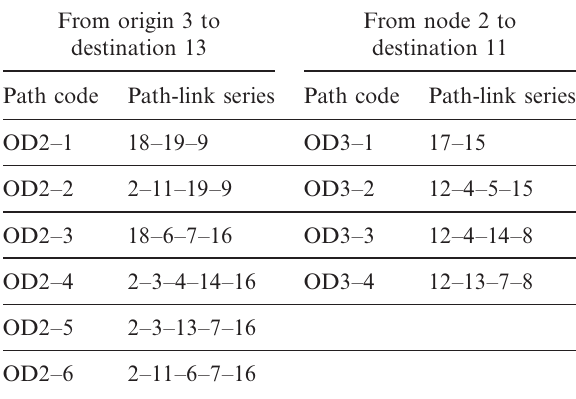
Table 1. Path-link series